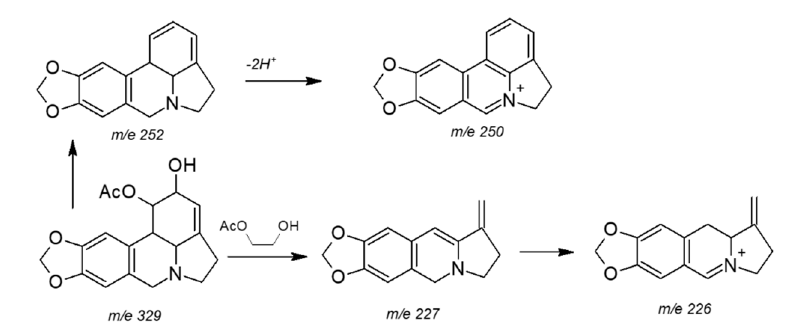
Figure 4. Proposed MS fragmentation pattern of the alkaloids isolated from Rhodolirium speciosum . Table 5. 1 H and 13 C-NMR data of alkaloids 1, 2, and 3 ( J in Hz) in CDCl 3